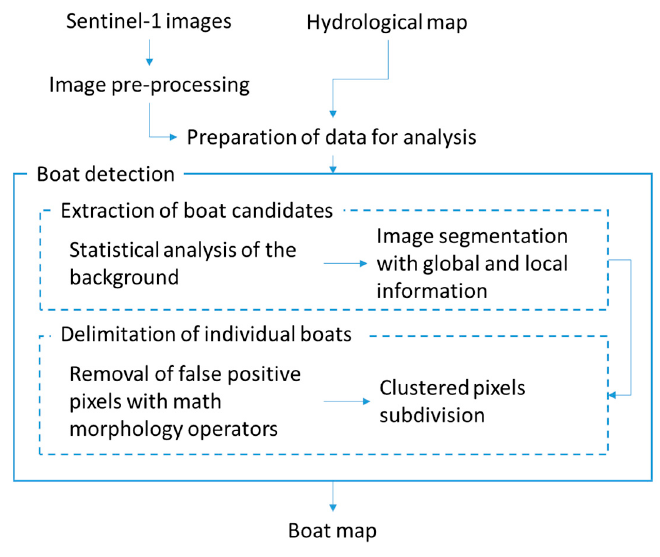
Figure 2. Boat detection workflow.